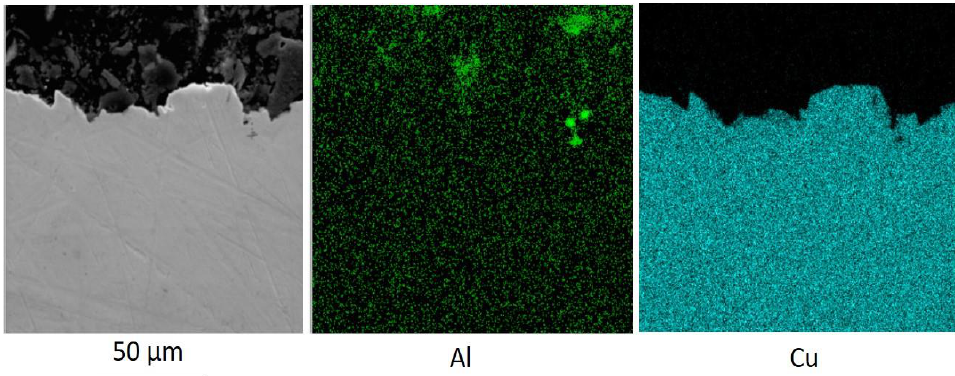
Figure 7. Microstructure and distribution maps of elements of a substrate without pretreatment after tearing off the coating sprayed with a mixture Cu-60% Al 2 O 3 .